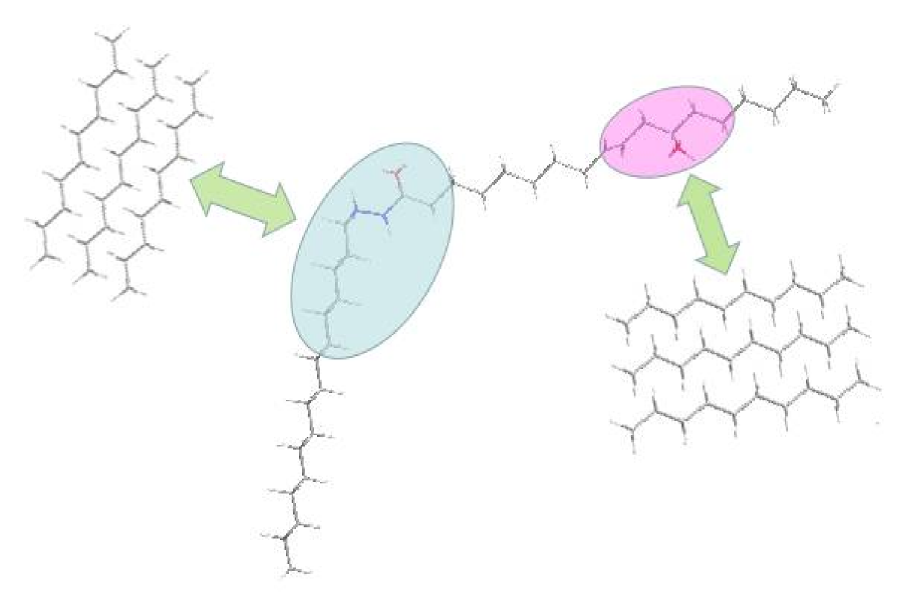
Figure 5. The steady conformations of CA C